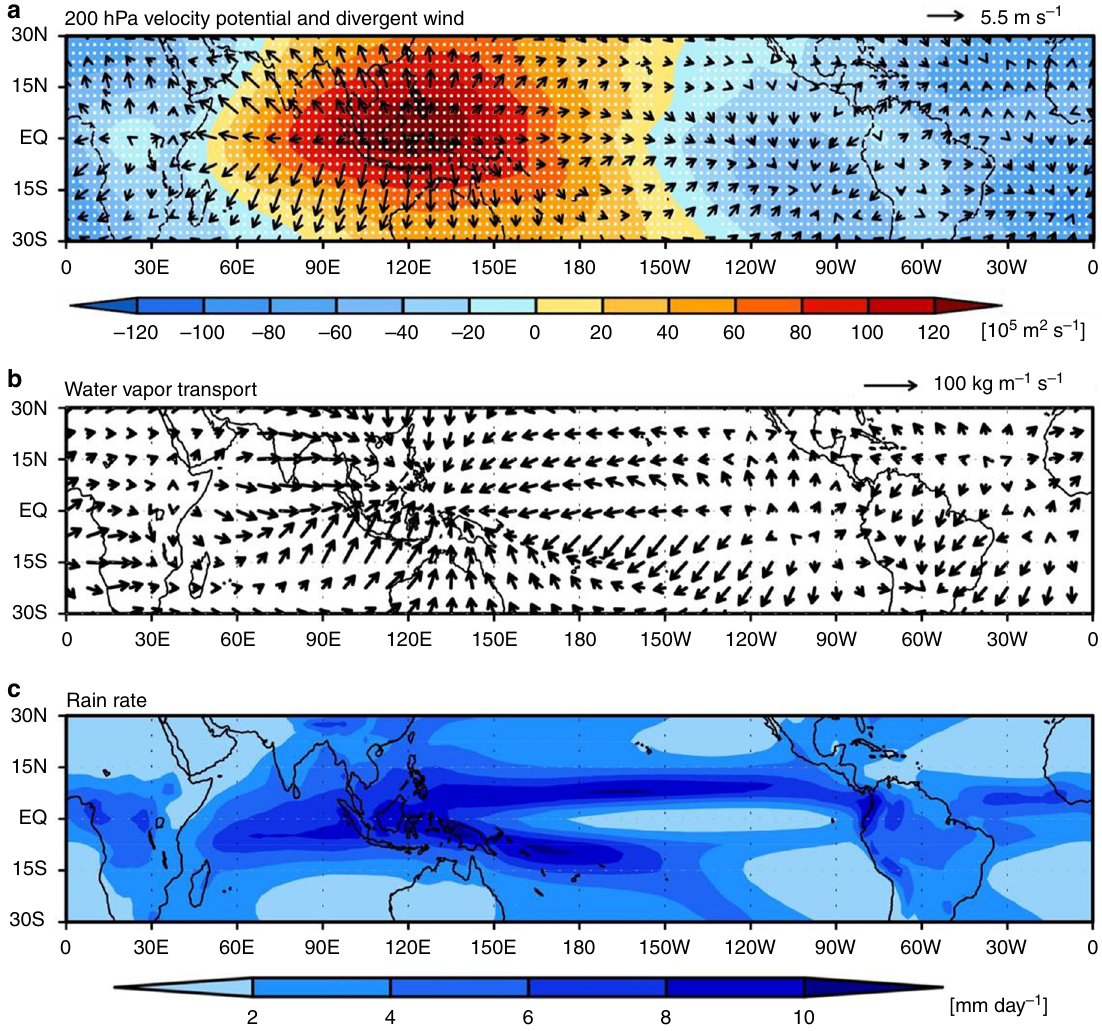
Fig. 1 Mass overturning circulation and precipitation in the tropics. The fi rst 20-year ensemble mean distribution of ( a ) velocity potential function (colors) and divergent wind (arrow) at 200-hPa level, ( b ) divergent water vapor transport [ Q D ], and ( c ) rain rate in the control run. Note that the zonal mean water vapor transport is removed in b . Dotted denotes the region where the responses of 14 or more out of the 21 CMIP5 models are of the same